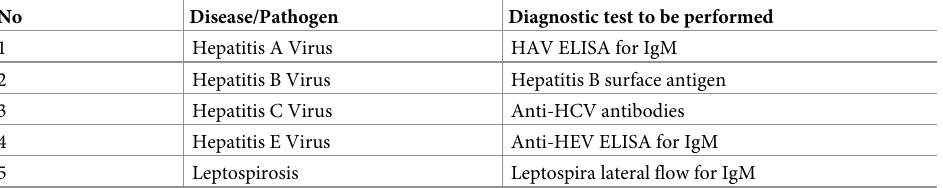
Table 1. Testing